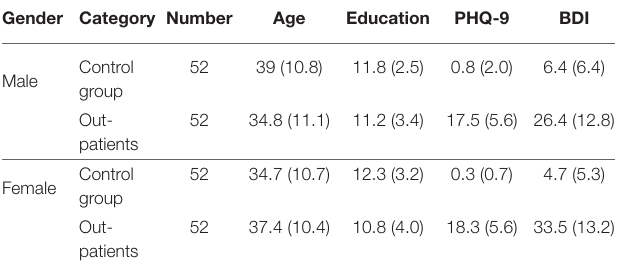
TABLE 1 | Demographic characteristic of the out-patients and control group: mean and (standard